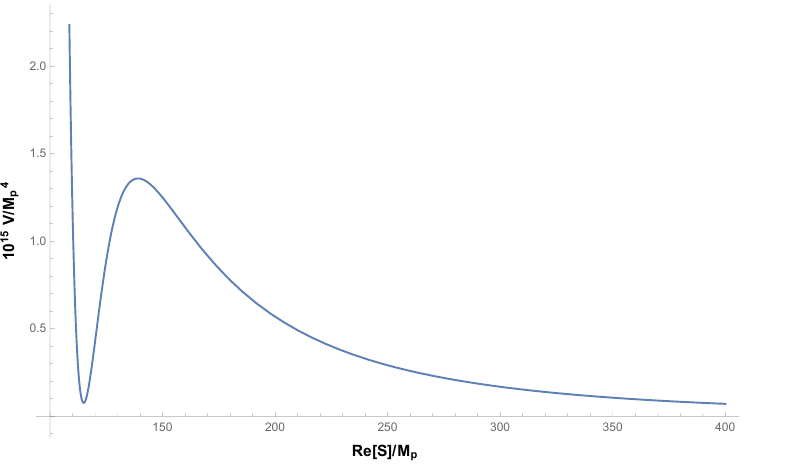
Figure 2 . The figure shows the KKLT scalar potential obtained from (4.13) for X = T = 0 and √ A = 1 , a = 0 . 1 , W 0 = − 10 − 4 , P = 80 ξ UV at the UV cut-off of the effective theory ( t = 0